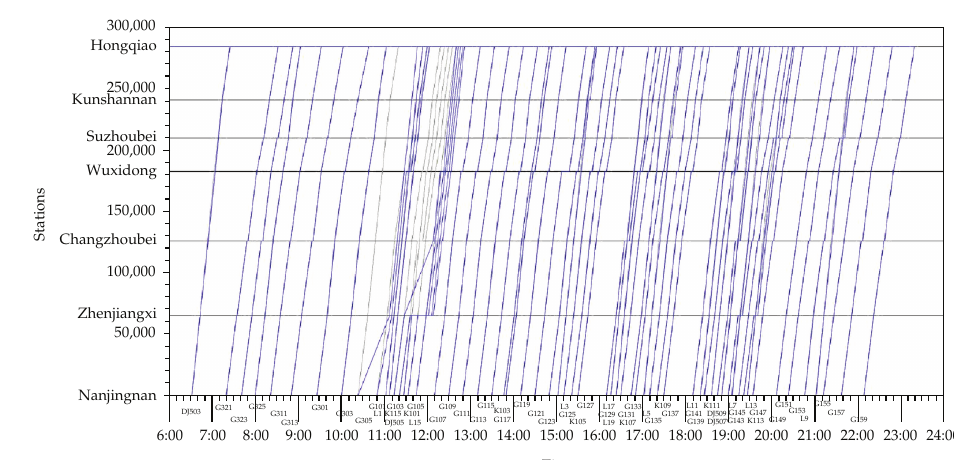
Figure 4: Timetable of two trains